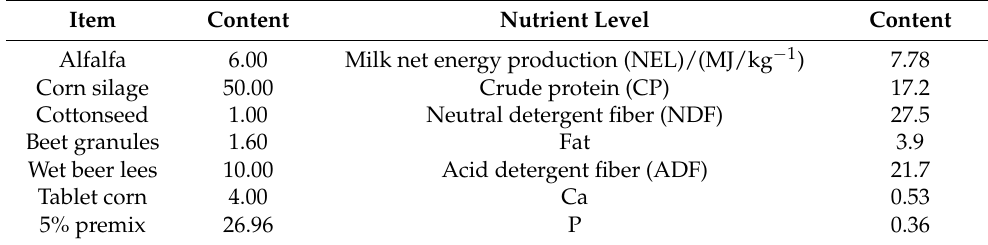
Table 2. The dietary composition and nutrient level (DM basis, %).